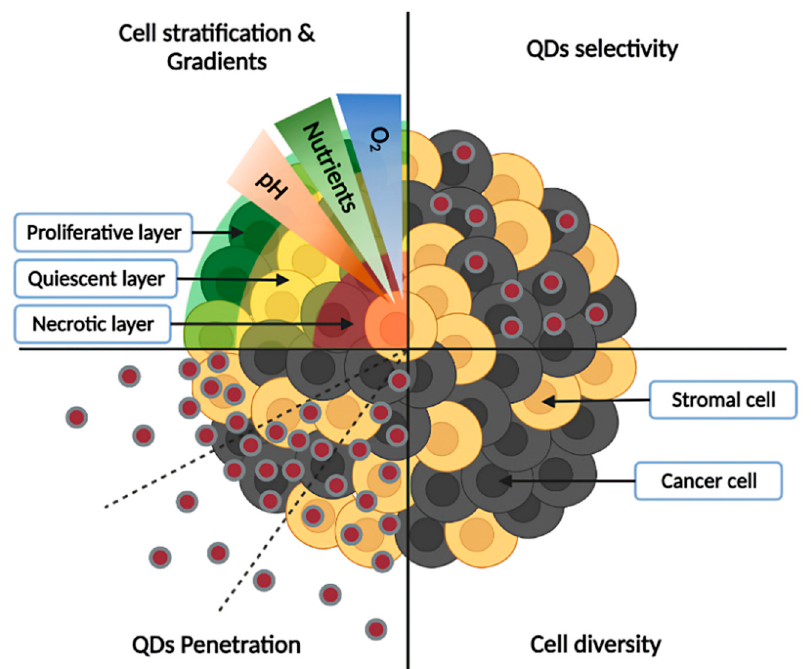
Figure 3. Characteristics of spheroid models and interest for QDs studies. Cell stratification into proliferative, quiescent, and necrotic layers, as well as the presence of gradients (low concentration of oxygen and nutrients in the core, accompanied by acidic pH) are depicted in the upper left panel, while cell diversity (presence of cancer and stromal cells) is illustrated in the lower-right panel. Spheroids allow the study of QDs penetration from the periphery to the core (lower-left panel), as well as their selectivity towards cancer cells (upper-right panel).